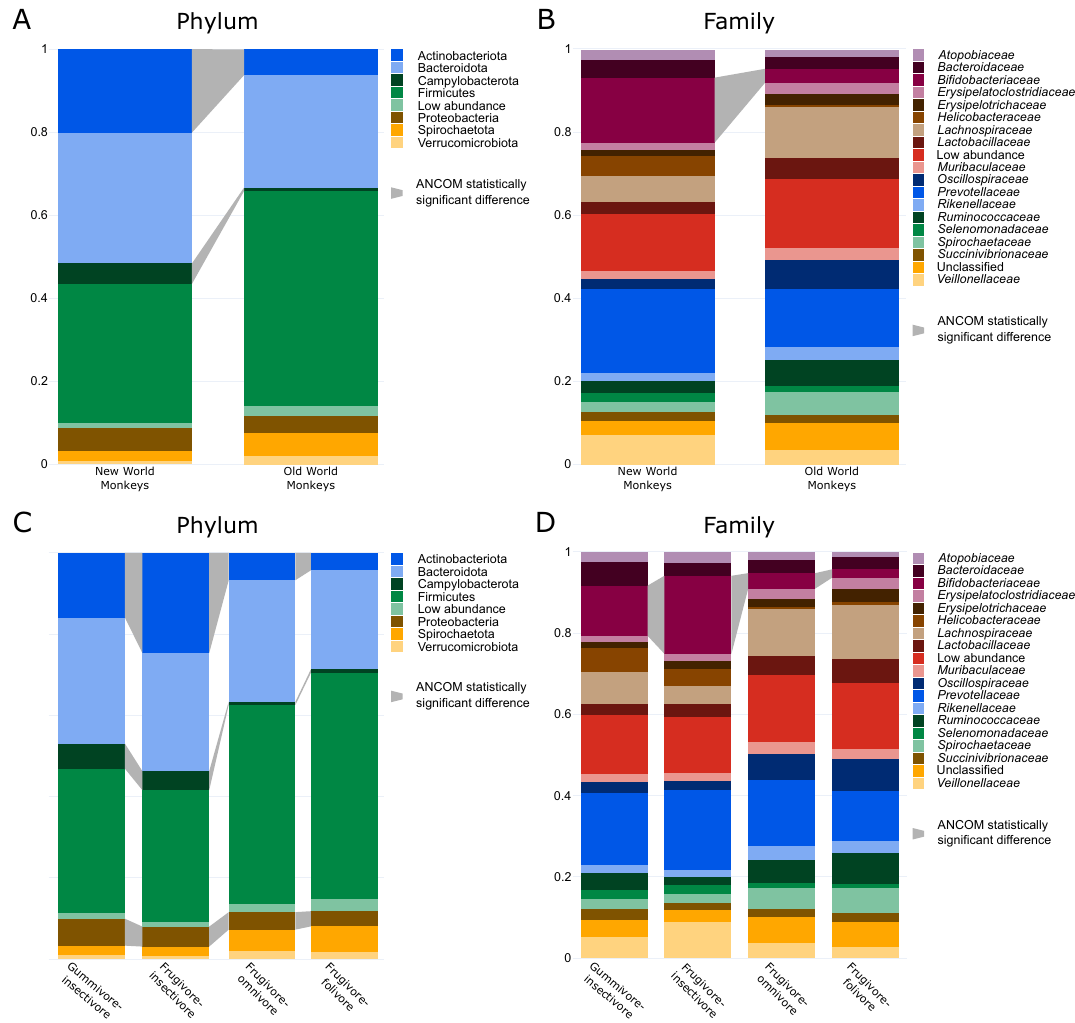
Figure 4. Relative abundance of primate gut microbiota. ( A ) Relative abundance of bacteria within parvorders on phylum level. ( B ) Relative abundance of bacteria within parvorders on family level. ( C ) Relative abundance of bacteria within feed categories on phylum level. ( D ) Relative abundance of bacteria within feed categories on family level. ANCOM statistically significant differences are denoted with grey